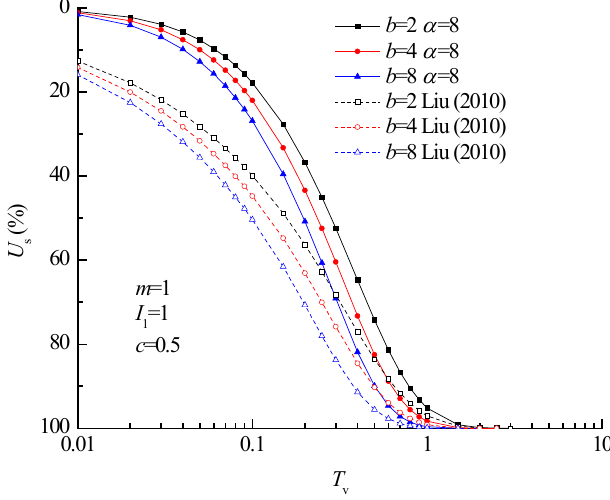
Figure 7. Influence of the b value on ACDS ( m = 1, c = 0.5) [23].